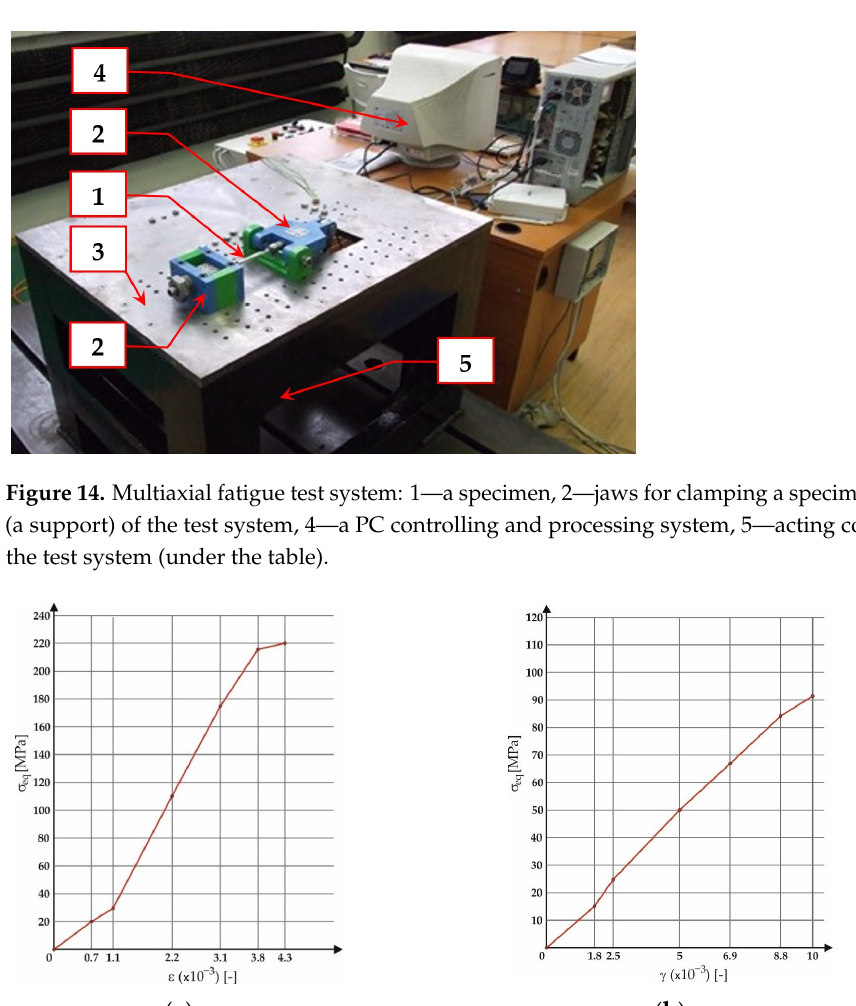
Figure 15. A function of equivalent von Mises stresses of EN AW6063 material tested with the proposed multiaxial test system and subjected to strain: ( a ) In bending; ( b ) In torsion.